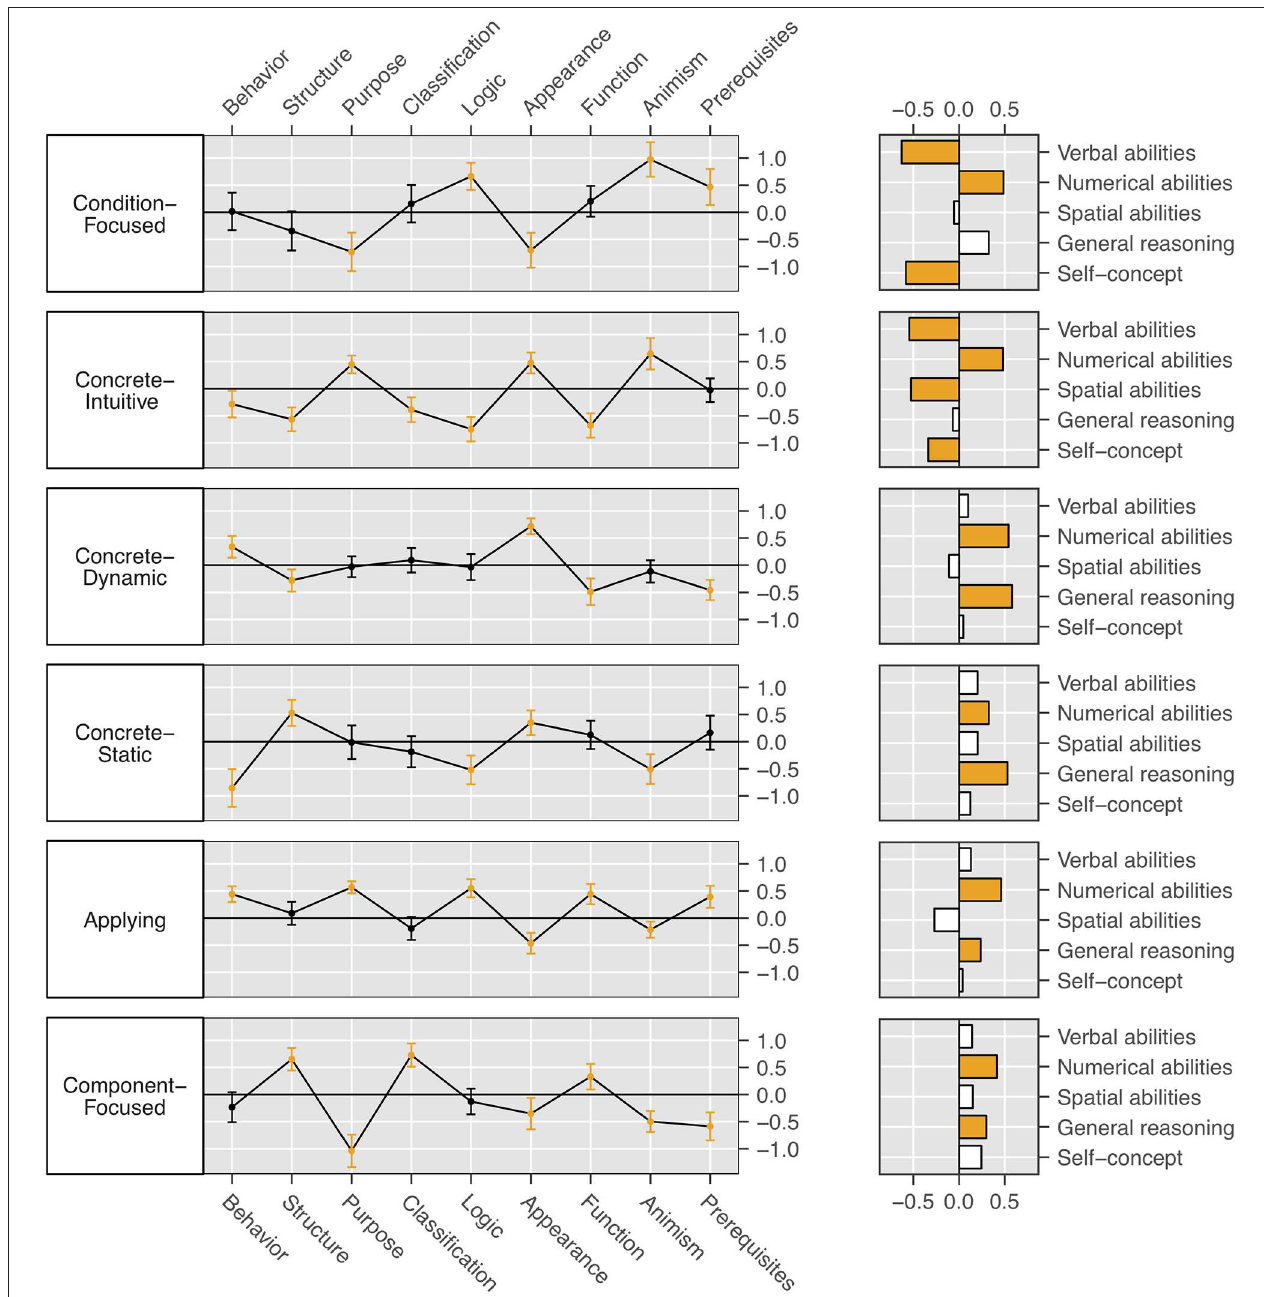
FIGURE 3 | Left: Cluster centers of the six ontological profiles (and 95% CIs), resulting from the cluster analysis of 340 university students based on the OCET, assessing nine ontological categories in engineering. Values are z -standardized for each ontological category on the total sample. Values differing significantly (i.e., p < 0.05) from the total sample are colored in orange. Right: Ontological profile-specific scores on the covariates compared to published reference values (i.e., general reasoning, verbal, numerical, and spatial ability; see Arthur and Day, 1994; Peters et al., 2006; Liepmann et al., 2007) or the sample mean (i.e., technology-related self-concept). Values are z -standardized for each covariate on the reference sample. Values differing significantly (i.e., p < 0.05) from the reference values are colored in